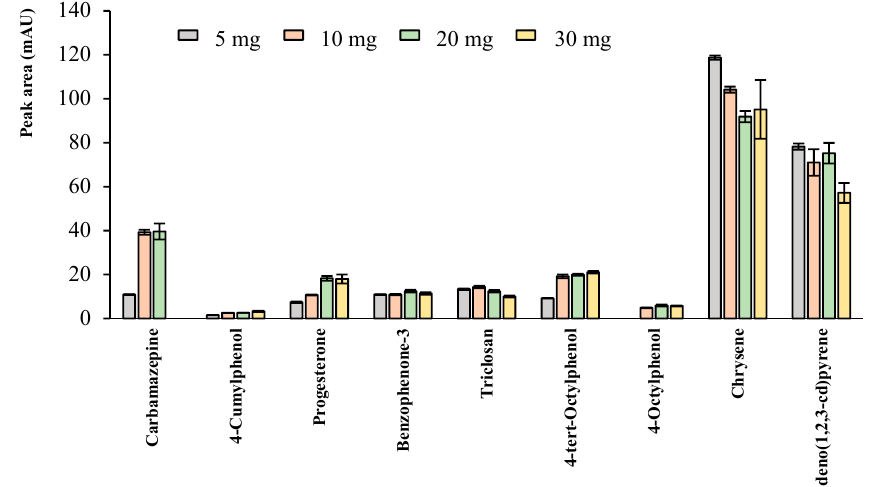
Figure 1. Effect of the amount of UiO ‐ 66 ‐ NO 2 on the extraction efficiency for all analytes in D ‐μ SPE ‐ HPLC ‐ DAD. Specific conditions are described in Section 3.4. Experiments were carried out in triplicate.